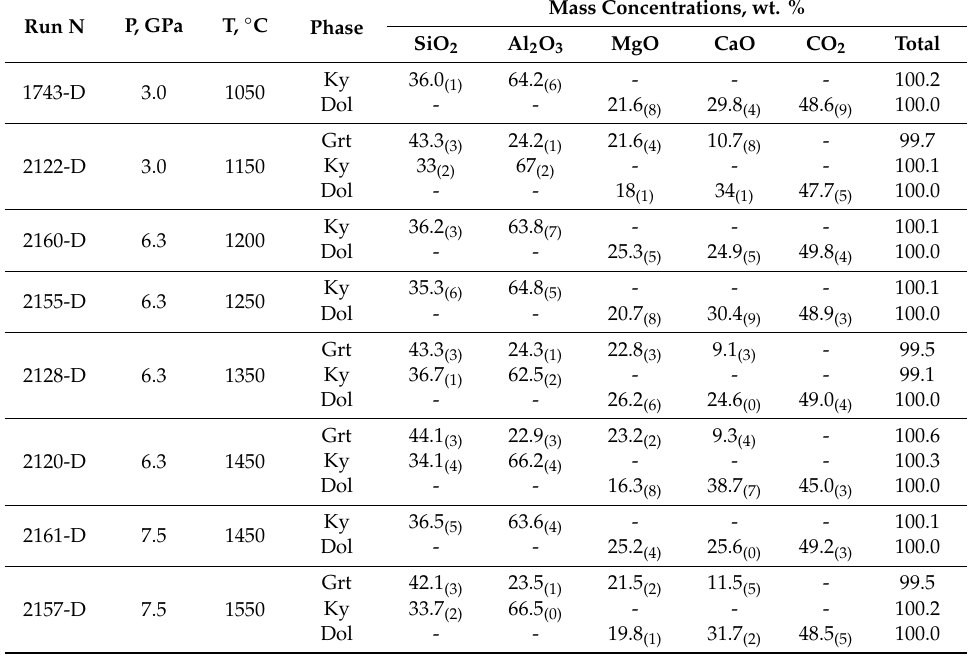
Table 5. Averaged compositions of garnets, kyanite, and carbonates after experiments in CaMg(CO 3 ) 2 -SiO 2 -Al 2 O 3